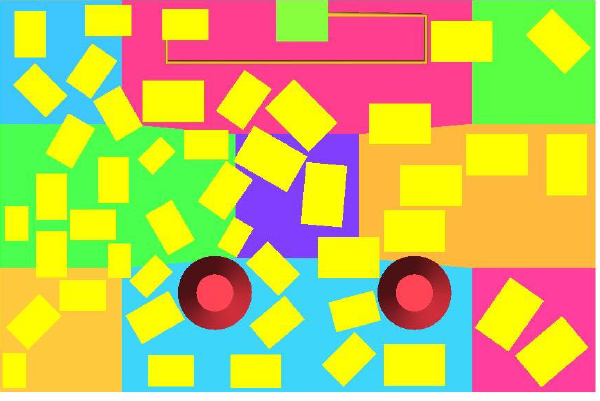
Figure 7. The distribution of block model broilers in the broiler chamber model.